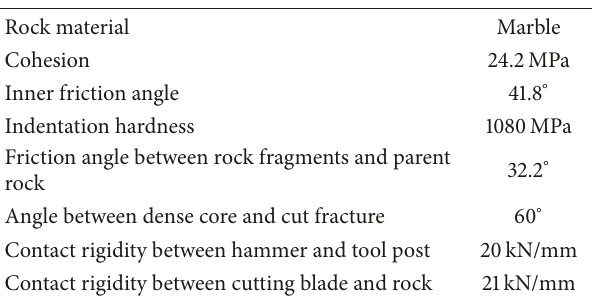
Table 2: Characteristic parameters in the rotary-percussive drilling load prediction model for lunar rock